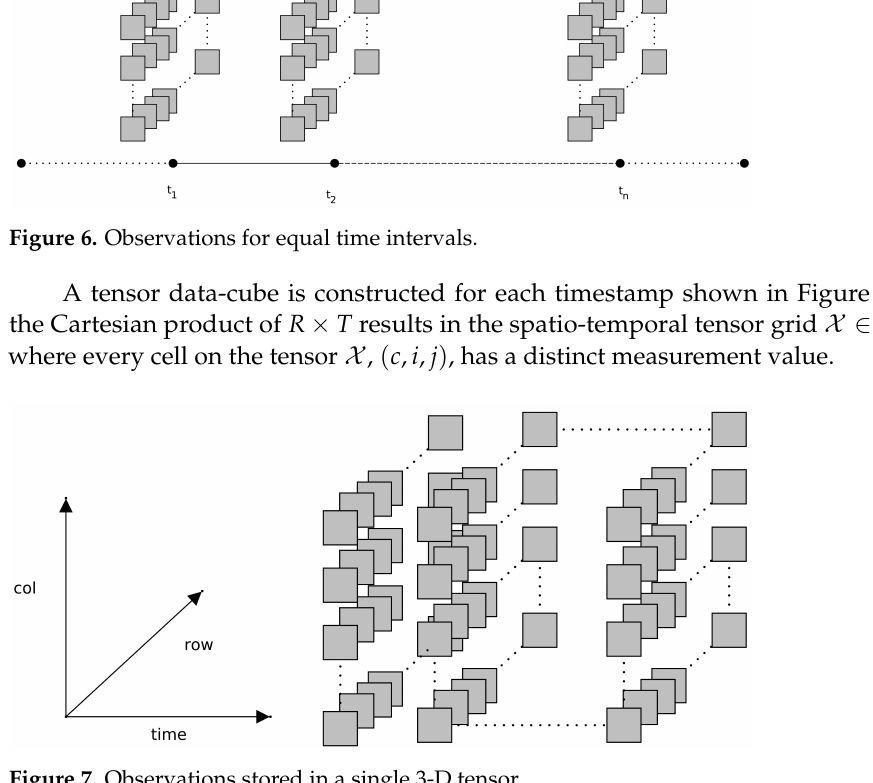
Figure 7. Observations stored in a single 3-D